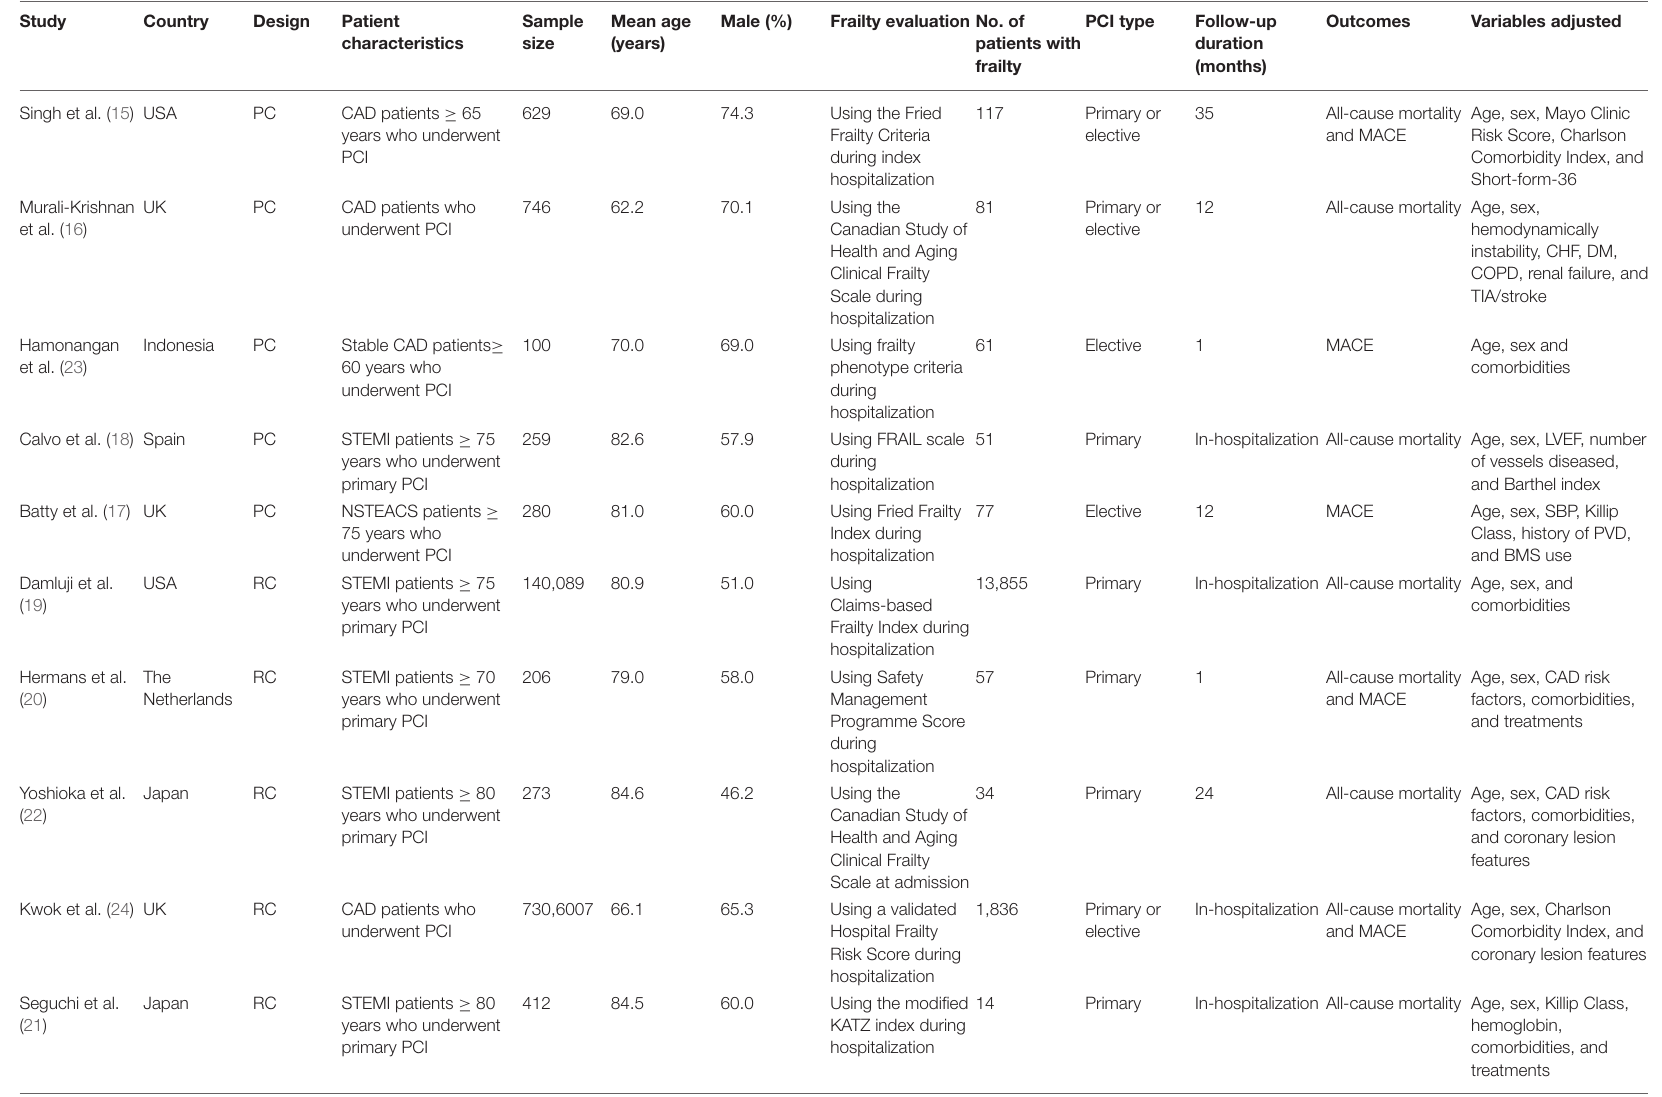
TABLE 1 | Characteristic of the included